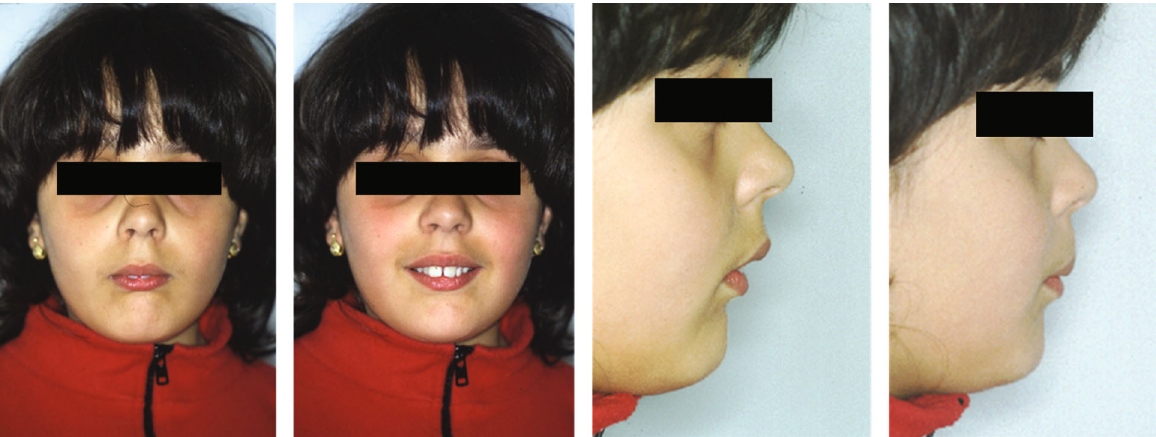
Figure 1: Initial extraoral photographs.